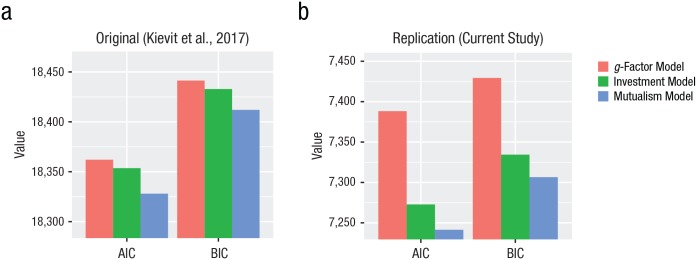
Akaike information criterion (AIC) and Bayesian information criterion (BIC) for the three models in the original article (a) and in the current replication (b). Lower values reflect better fit.